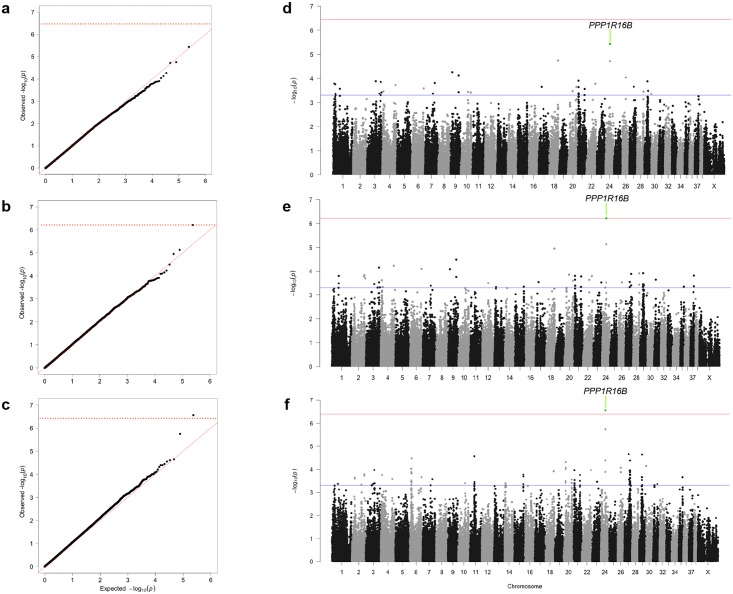
Linear mixed model GWAS corrects for population structure and identifies 99 ACL associated loci explaining a large proportion of phenotypic variance.For each linear mixed model (LMM), the QQ plots show no evidence of population stratification relative to the expected distribution. Permutation testing with each model determined genome-wide significance at (a) P<3.63E-7 for GCTA (Genome-wide Complex Trait Analysis) [33], λ = 0.987 (b) P<6.097E-7 for GEMMA (Genome-wide Efficient Mixed Model Association) [34], λ = 0.994 and (c) P<4.01E-7 for PUMA (Penalized Unified Multiple-locus Association) [35], λ = 1.012. The plots represent analysis of 118,992 SNPs from 98 cases and 139 phenotype-negative controls. (d) With GCTA, 36 loci have P<5E-4, with the most significant locus located in CFA 24, which did not meet genome-wide significance defined by minimum p-values from permutation testing. (e) With GEMMA, 47 loci have P<5E-4, with the locus on CFA 24 meeting genome-wide significance defined by minimum p-values from permutation testing. (f) With PUMA, 65 loci were significant at P<5E-4 and the locus on CFA 24 exceeded genome-wide significance defined by minimum p-values from permutation testing. The single SNP that met genome-wide significance lies within the gene PPP1R16B.